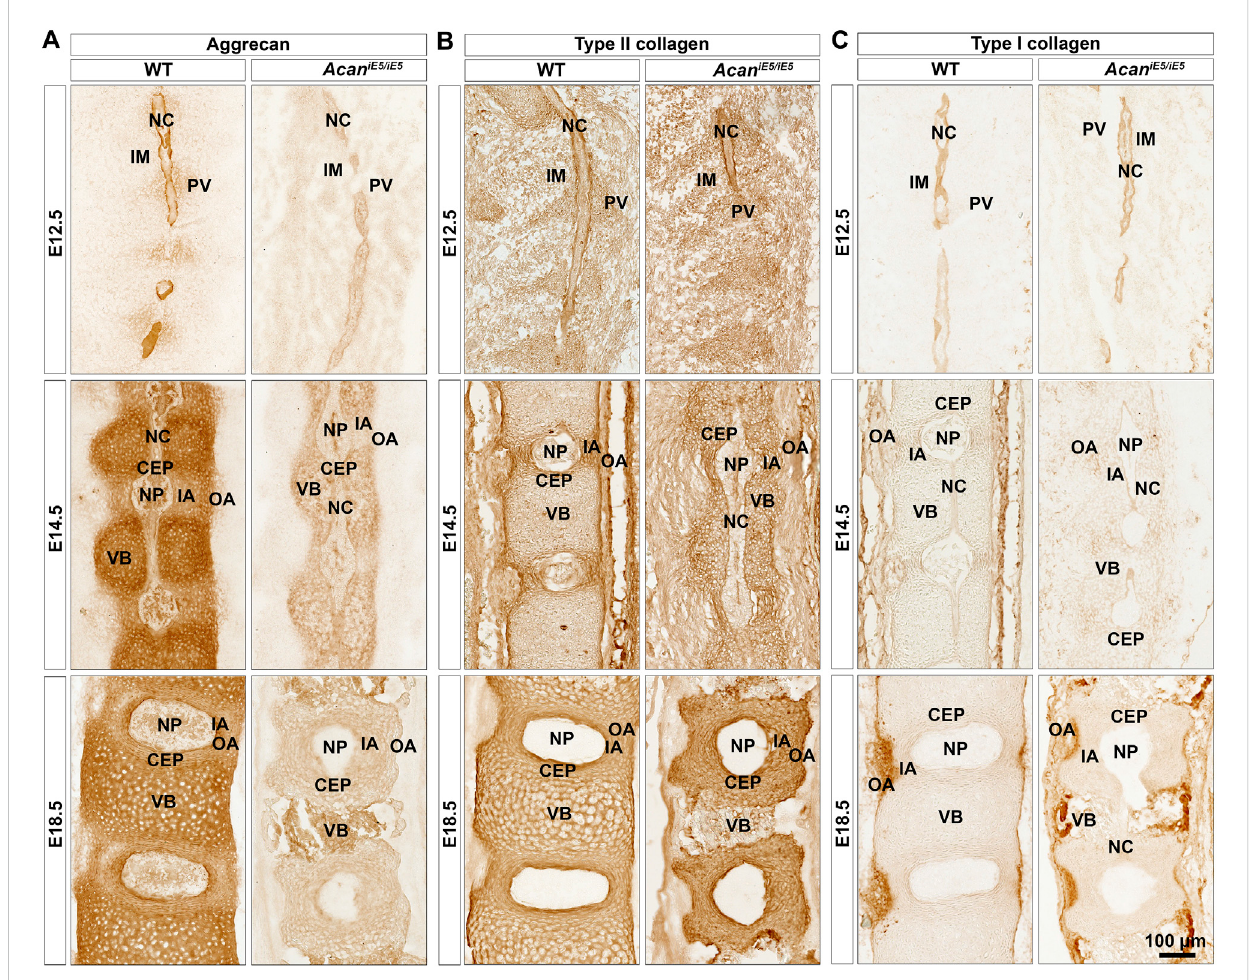
FIGURE 4 Immunohistochemistry against aggrecan (A) , type II collagen (B) and type I collagen (C) on the cervical portion of vertebral columns in WT and Acan iE5/iE5 mice at E12.5, E14.5 and E18.5. (A) Representative pictures demonstrating the expression pattern of aggrecan in the developing spine tissues in wild type, and its almost total absence in mutant mice. (B) Type II collagen deposition was not affected in Acan iE5/iE5 mice. (C) Type I collagen expression wascomparablebetweenthegenotypes. Bar,100 µm.The mid-sagittalsectionsinallpanelsarepresentedatthesamescale.Top-bottomand left- right of every picture correspond to the rostral-caudal and ventral-dorsal anatomical orientations, respectively. Abbreviations: NC, notochord; IM, intervertebral mesenchyme; PV, prevertebrae; NP, nucleus pulposus; VB, vertebral body; CEP, cartilage end plate; IA, inner annulus fi brosus; OA, outer annulus fi